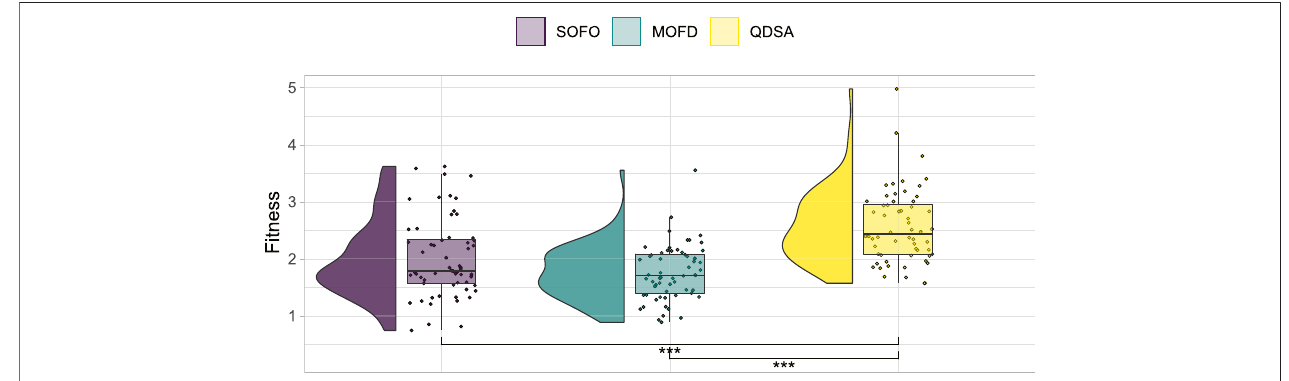
FIGURE 2 | Summary of parameter optimization. All 60 runs for each search algorithm are shown together with the result of a Mann-Whitney U test which show statistically signi fi cant differences between QDSA and the two other search algorithms.